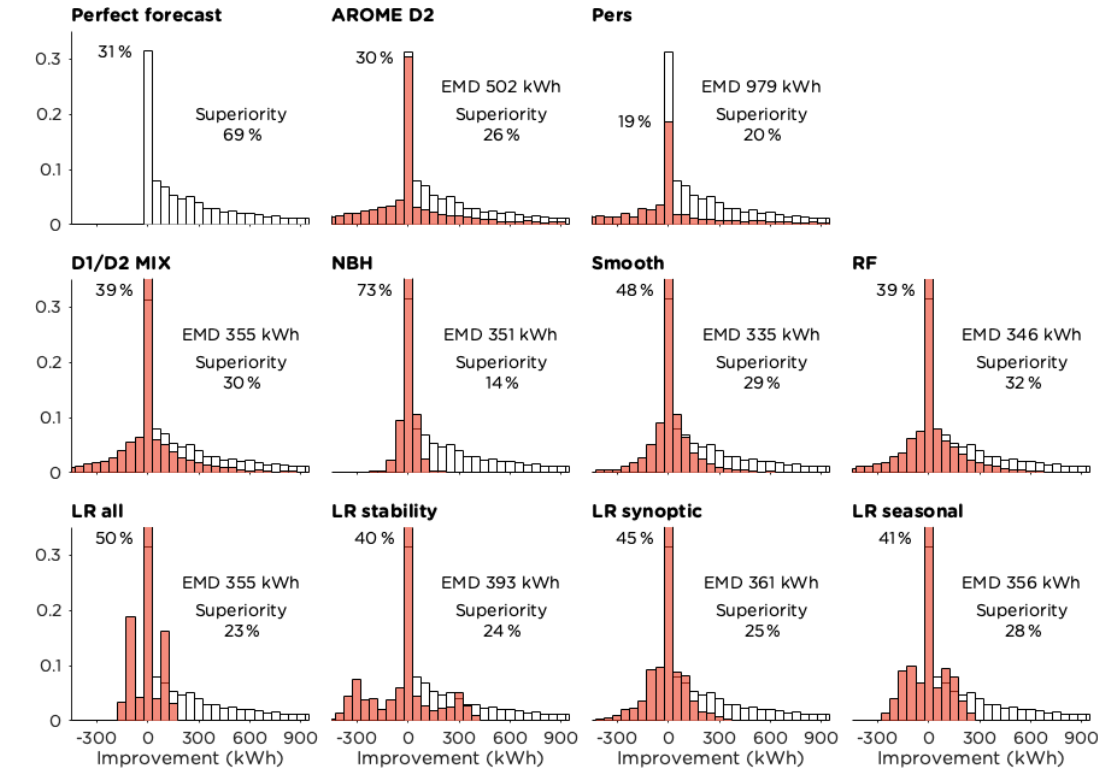
Figure 8. Frequency distributions showing the forecast improvement compared to AROME D1 in kWh for the different methods tested. The methods are compared to a perfect forecast (white bars), and the EMD values between the two distributions are given. The forecast superiority (improvements greater than 25kWh) is presented and also the percentage of the time steps with minor alterations of the original forecast (changes less than ±